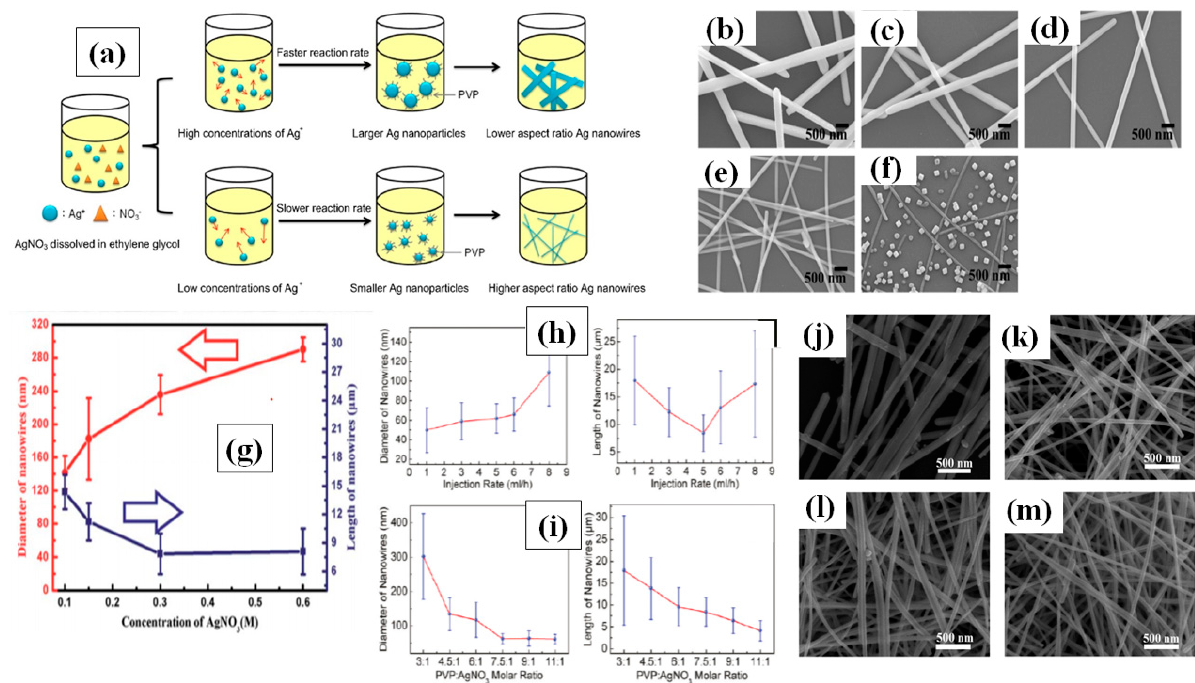
Figure 6. ( a ) A schematic of the different concentrations of silver nitrate to change the AgNW diameter. The synthesis of AgNWs using different concentrations of silver nitrate; ( b – f ) PVP/silver nitrate molar ratios are ( b ) 2, ( c ) 4, ( d ) 8, ( e ) 16, and ( f ) 32, respectively. (adapted from [103] with permission from Elsevier, 2015) ( g ) Changes in nanowire diameter and length as a function of the AgNO 3 concentration (adapted from [104] with permission from Royal Society of Chemistry, 2014). ( h ) Shows the Changes in nanowire diameter and length with different injection rate. ( i ) shows the changes in nanowire diameter and length with PVP:AgNO 3 molar ratio. (adapted from [101] with permission from ACS publications, 2012) ( j – m ) FE-SEM images of AgNWs synthesized with PVP molecules of different chain lengths ( j ) PVP-55,000, ( k ) PVP-360,000, ( l ) PVP-1,300,000, and ( m ) PVP-1,300,000 + PVP-55,000 (a weight ratio of 1:1) (adapted from [105] with permission from ACS publications, 2012))